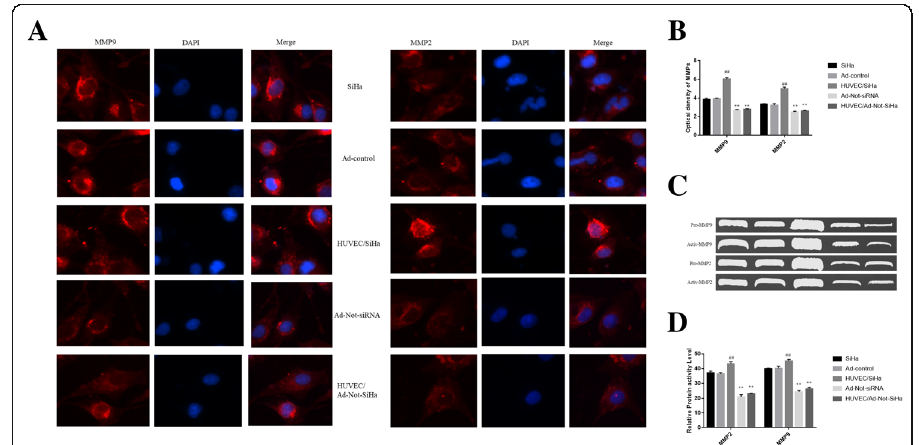
Fig. 5 Changes of MMP-2 and MMP-9. a Immunofluorescence assays of MMP-2 and MMP-9; b Optical density of immunofluorescence; c Gelatin zymography – the activity of MMPs; d Differences analysis of MMPs ’ gelatin enzyme spectrum. Compared with the Ad-Control group, ## P < 0.01; compared with the HUVEC/SiHa group, ** P <